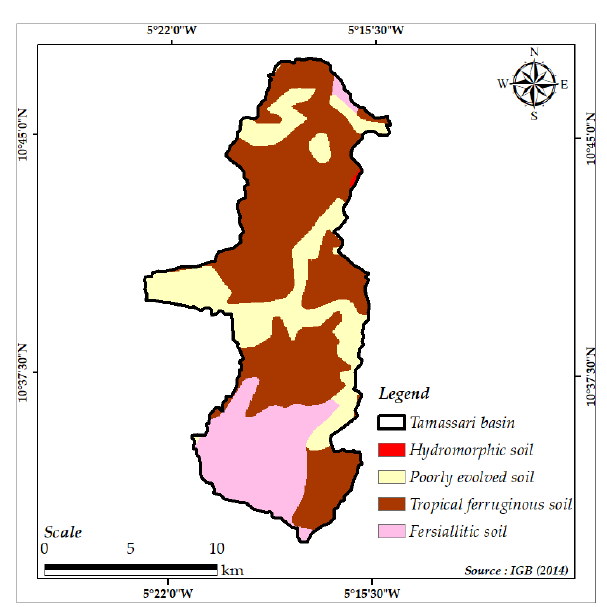
Figure 10. Slope mapping.